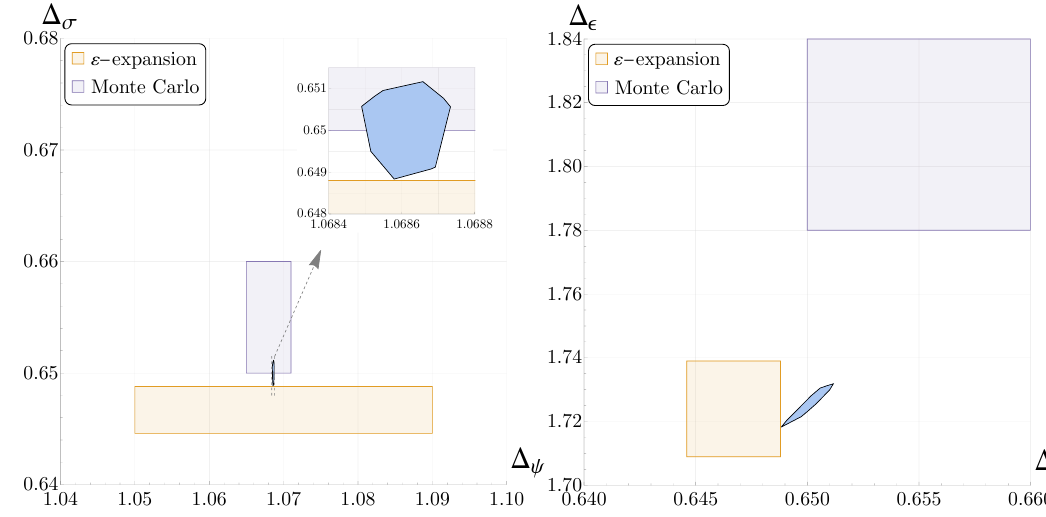
Figure 5 . The allowed region for the N = 2 critical GNY model when imposing that ∆ σ 0 > 3 computed at n = 18 , projected to the (∆ max to the Borel re-summed result obtained from the (cid:15) -expansion [31] (shown in orange) and with the Monte Carlo results from [39] (shown in